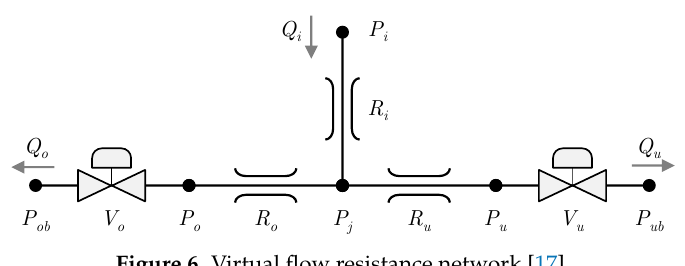
Figure 6. Virtual flow resistance network